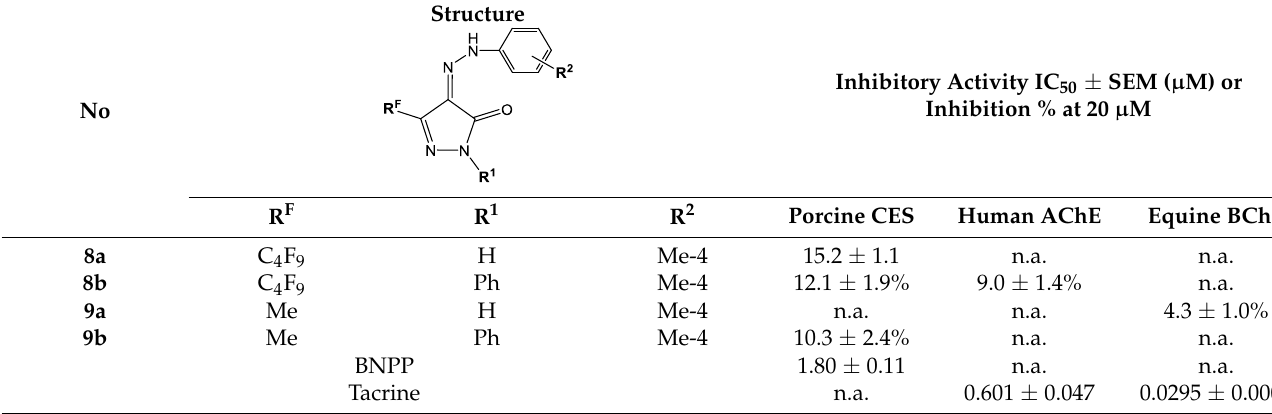
Table 3. Cont. Table 3. Esterase profile of 4-AHPs 5 – 9 .